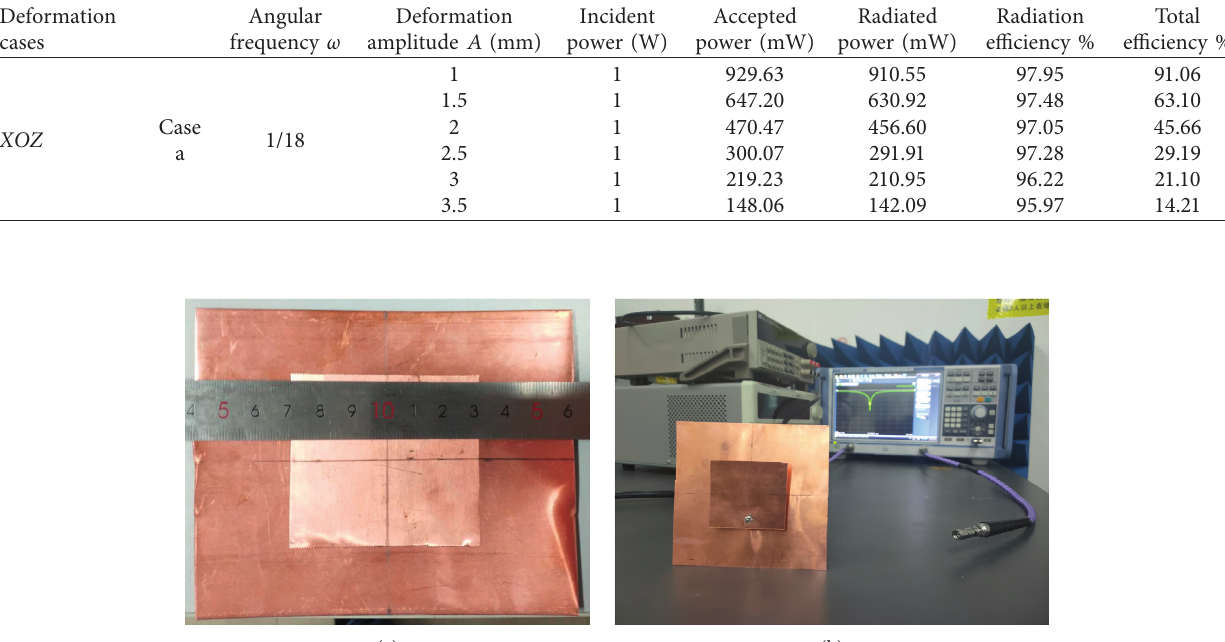
Table 4: Efficiency of air microstrip antenna.